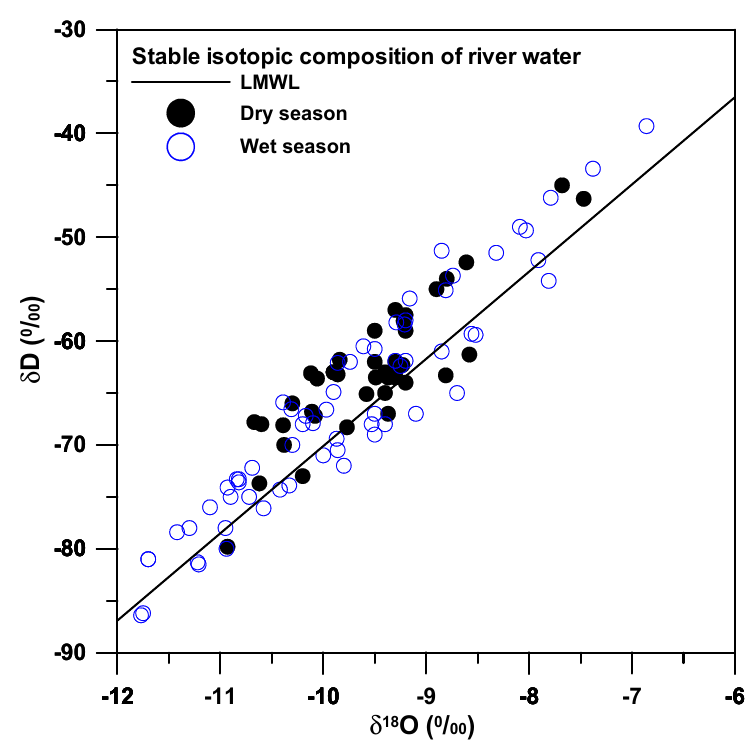
Figure 3. Plot of δ D vs. δ 18 O for river water samples. The LMWL is established as δ D = 8.40 δ 18 O + 13.89 for local